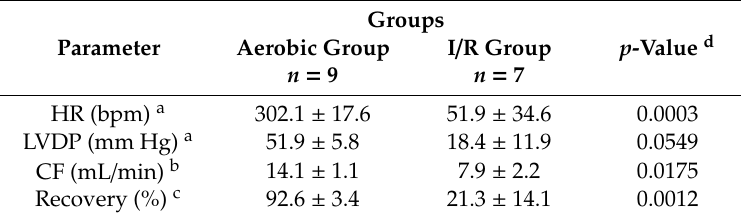
Table 1. E ff ect of ischemia / reperfusion injury on heart rate, left ventricular developed pressure, and coronary flow of isolated rat